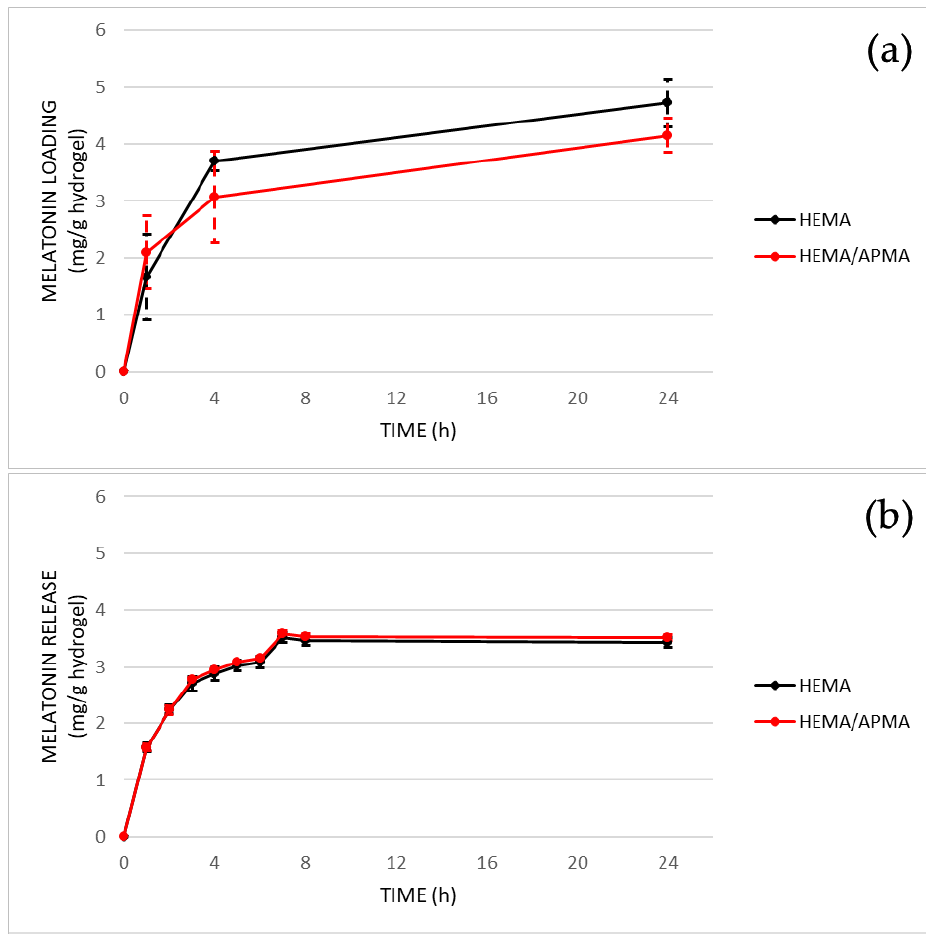
Figure 4. In vitro profiles of melatonin loading ( a ) and release ( b ) with both HEMA and HEMA/APMA contact lenses ( n = 4). No statistically significant differences were found between both contact lens materials at any time point ( p ≥ 0.05, Mann–Whitney U test).